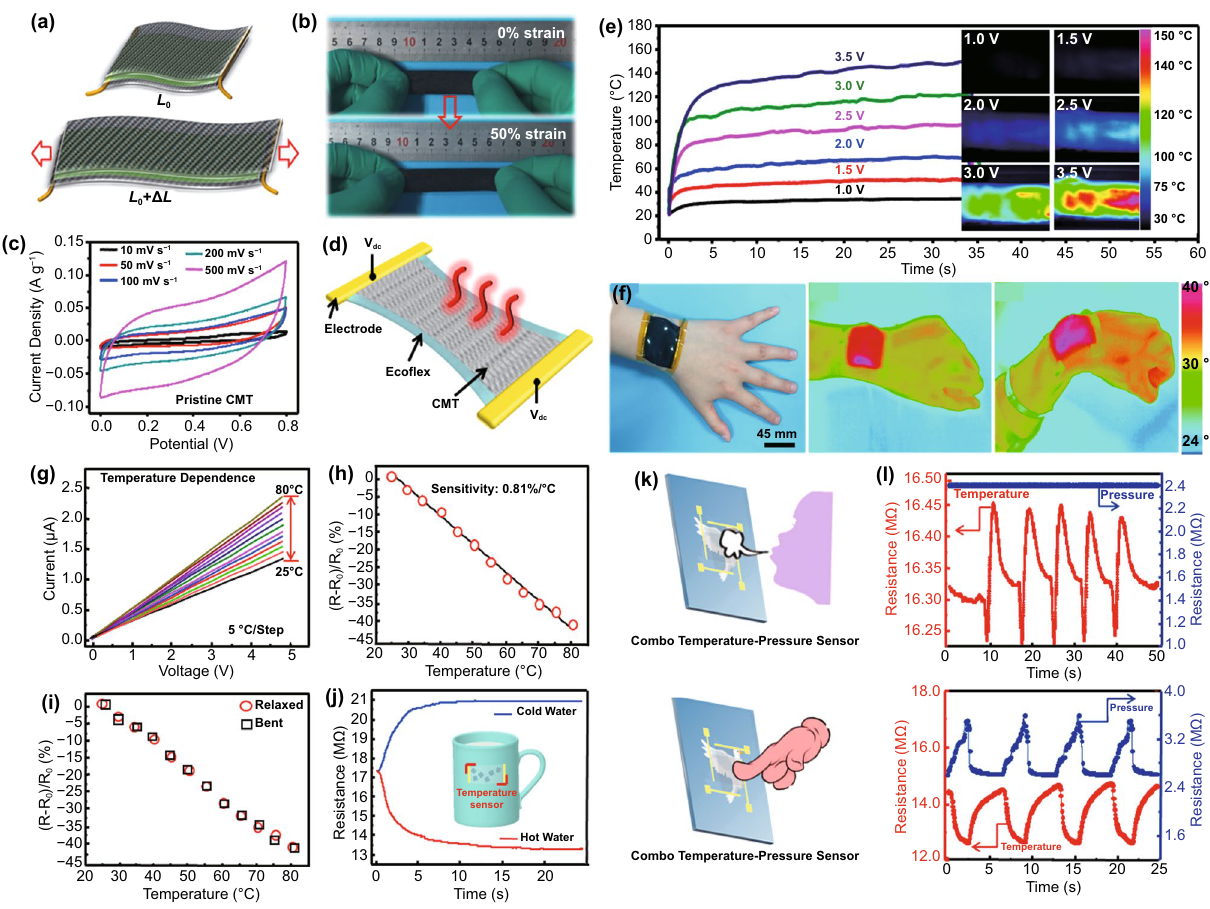
Fig. 13 a Schematic of the stretchable CMT-based supercapacitor. b–c Photo image of the supercapacitor under the original state and strain of 50% and the current–voltage curves at different scan rates. d Schematic of stretchable CMT-based heater. e Time–temperature curves of the CMT heater under different voltages from 1 to 3.5 v. f A CMT heater affixed on a wrist and the corresponding IR images with the wrist under relax and bending state [144]. Copyright © 2017 American Chemical Society. g–j I–V curves, the relative resistance change with the tempera- ture range from 25 to 80 ℃ , and the resistance change with the temperature sensor under relaxed and bent conditions. j Resistance response to cold water and hot water. k–l Schematic illustration and the sensing performance of the E-skin under exhaling stimulus and finger pressing stimulus simultaneously [219]. Copyright © 2017 American Chemical